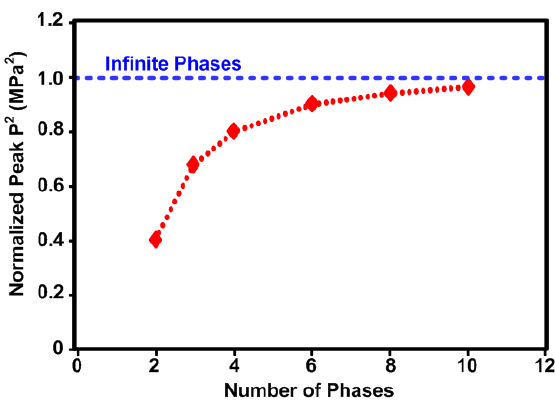
Figure 10. The impact that the number of phases used in a HIFU phase array has on the peak pressure amplitude square (P 2 ), simulation reproduced from